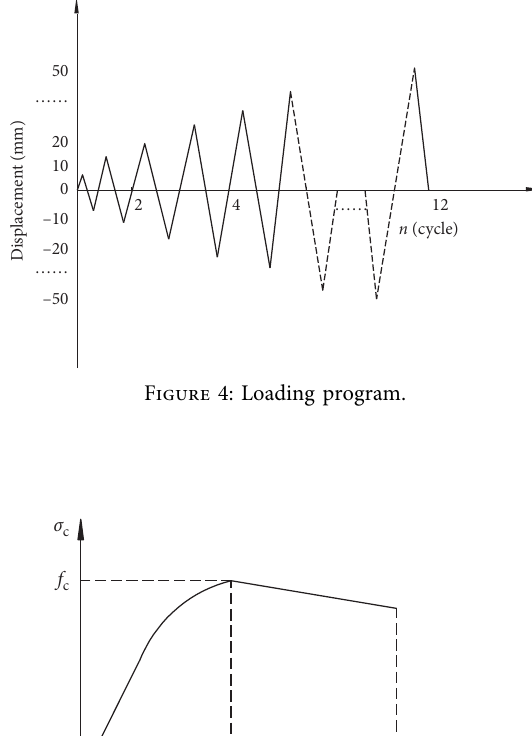
Figure 5: Concrete model.